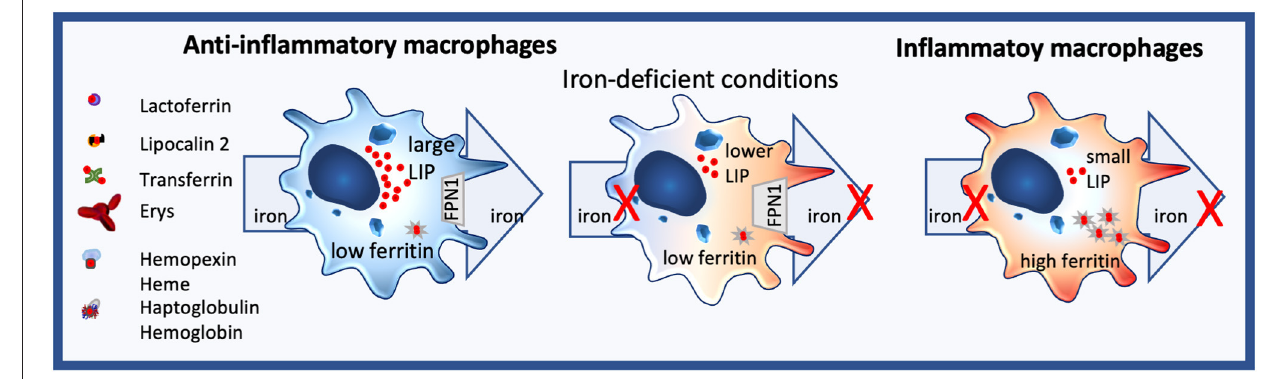
FIGURE 2 | Iron homeostasis in macrophages. Anti-inflammatory macrophages constantly take up but also export iron and are characterized by a large labile iron pool (LIP) and low ferritin levels. In contrast, inflammatory macrophages neither import nor efflux iron, their LIP is small, while ferritin expression is high. Under iron-deficient conditions, no iron can be distributed by anti-inflammatory macrophages, changing their phenotype towards a more inflammatory